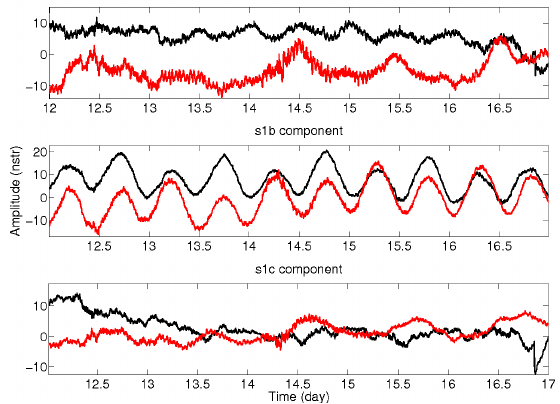
Figure 14. 5 days of residual noise level (high-pass filtered) at 2- days period on two data sets (black (June 2010) and red (December